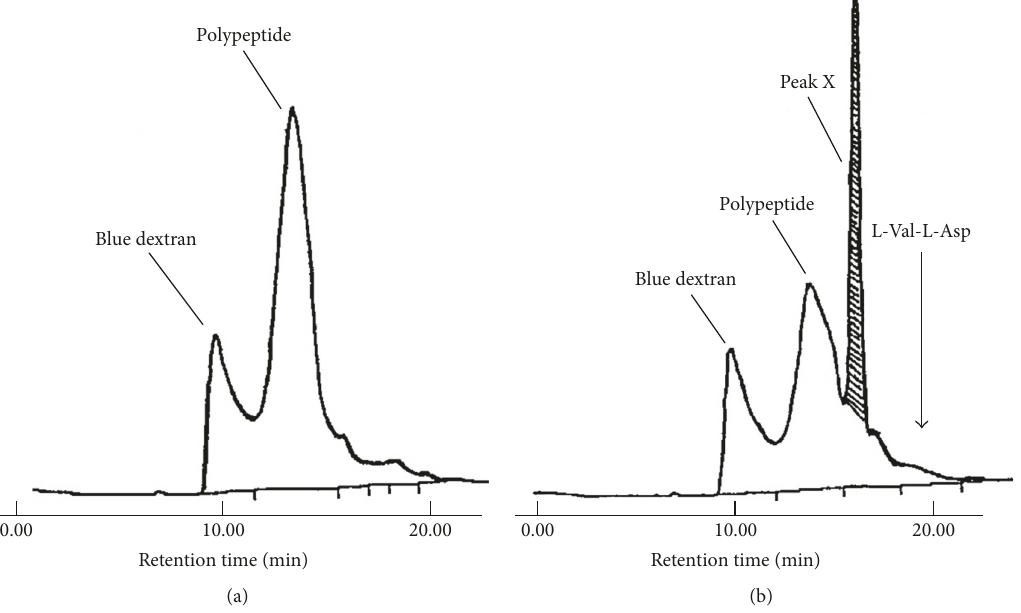
Figure 12: Chromatograms of the crude products obtained from Boc-Gly-Gly-L-Asp (a) at 120 ∘ C for 4h and Boc-L-Val-L-Asp (b) at 130 ∘ C for 2 h in the heating reactions using an HPLC equipped with a TSK-GEL G-3000PW (300 mm × 7.5 mm i.d.). Eluent: 0.1M sodium phosphate buffer, pH 6.9; flow rate: 0.7 mL/min; detection: UV 230 nm.